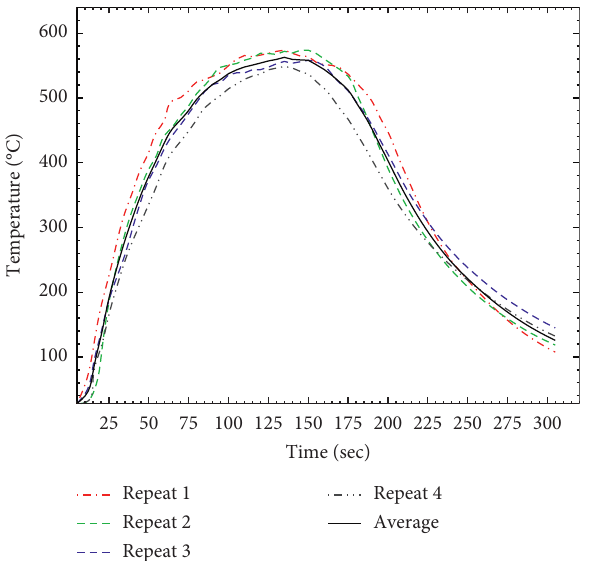
Figure 5: Flame temperature versus time: case study of free fire with fire source 6. Table 3: Application of Cochran’s test on data of free fire tests. Fire source